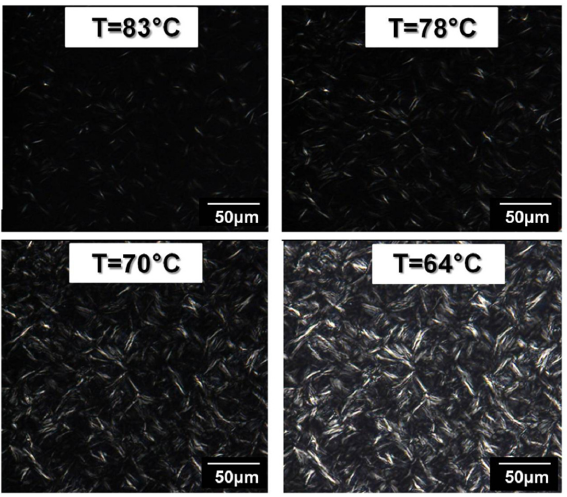
Figure 12. PE lamella crystallization in PE-b-PEG C (83 wt. % PEG) observed by optical microscopy in combination with polarized light during a cooling